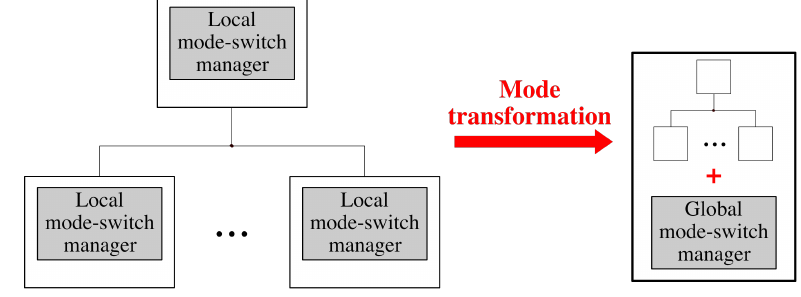
Figure 8. The overview of mode